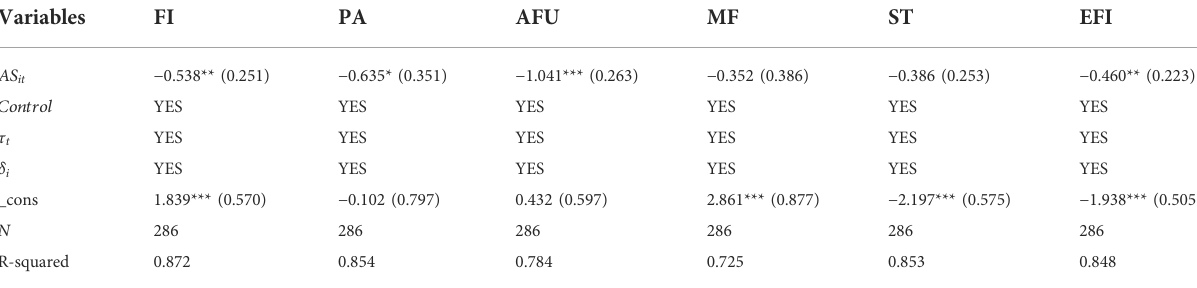
TABLE 7 Robustness